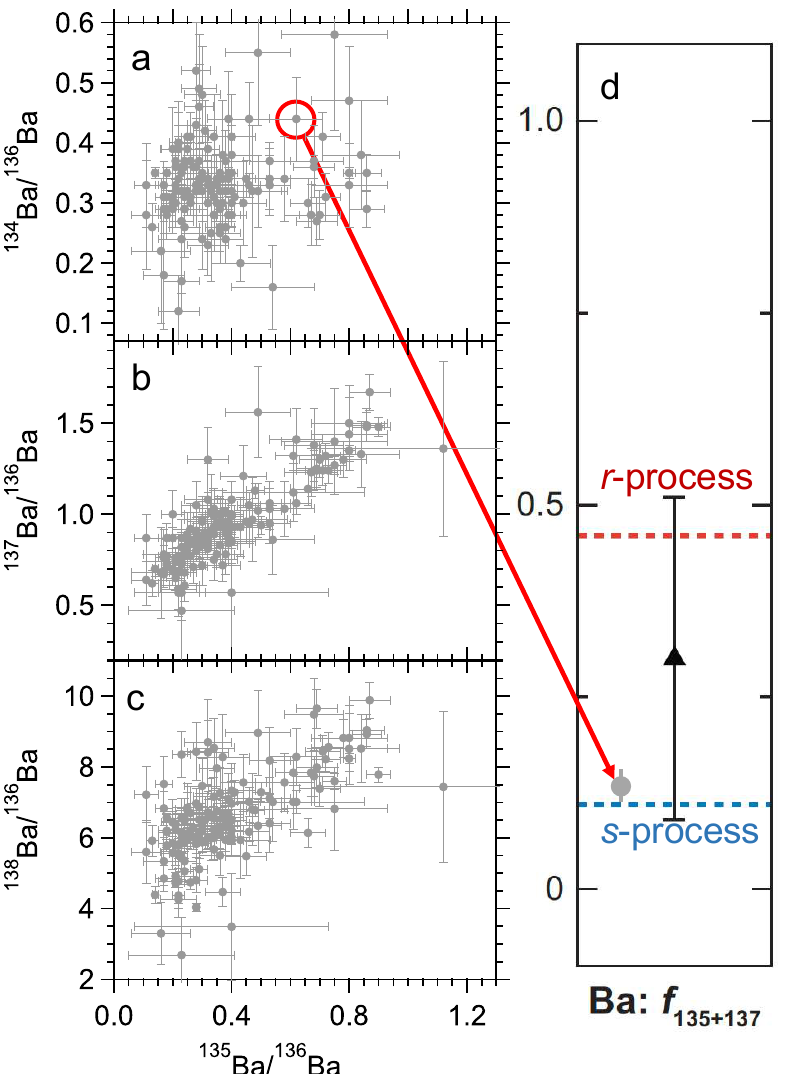
Figure 3. Panels ( a – c ): RIMS Ba isotope data of MS and unclassified grains [34,62,64,79,80]; panel ( d ): the Ba isotope ratio of a randomly selected MS grain (highlighted by the red circle in panel ( a )) compared to the spectrographic data of a metal-poor subgiant HD 140283 ([Fe/H]~ − 2.4) [78]. In panel ( d ), f 135+137 denotes the fraction of 135 Ba and 137 Ba among all Ba isotopes. The dashed red and blue lines in panel ( d ) denote the pure- r -process and pure- s -process predictions, respectively [72]. Error bars are all 1 σ.